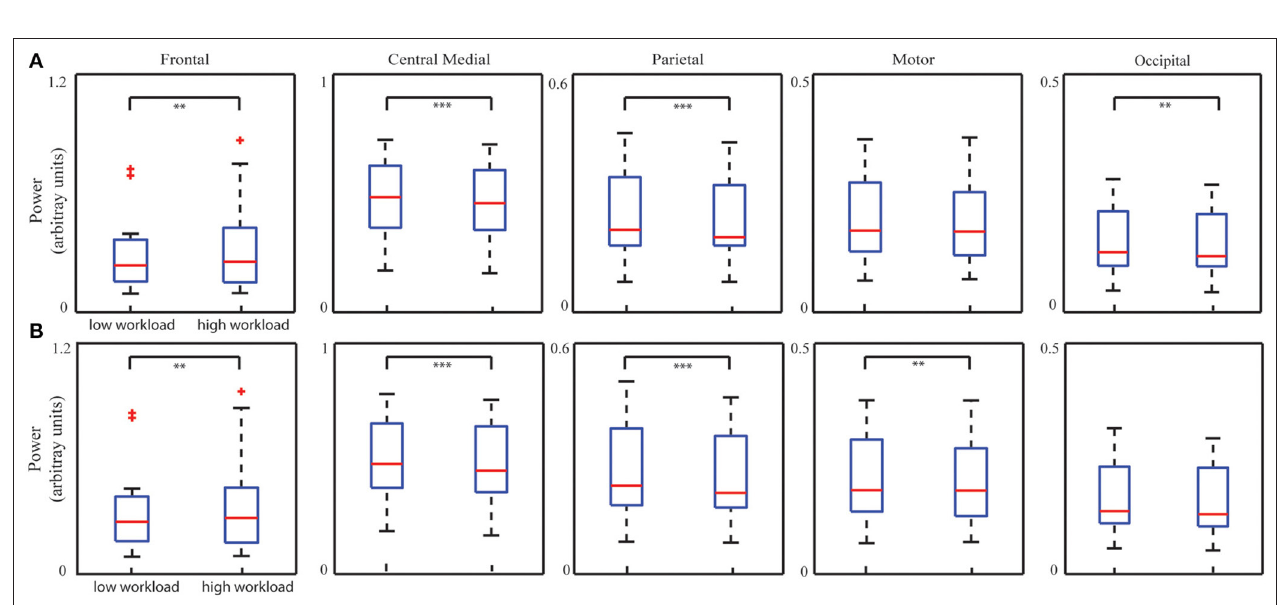
FIGURE 5 | Whisker plots of averaged IC PSDs at corresponding dominant freqency bands from all the sessions of all subjects in low and high mental effort conditions with (A) or without (B) removing TOT-related PSD changes. ** p < 0.01, corrected.